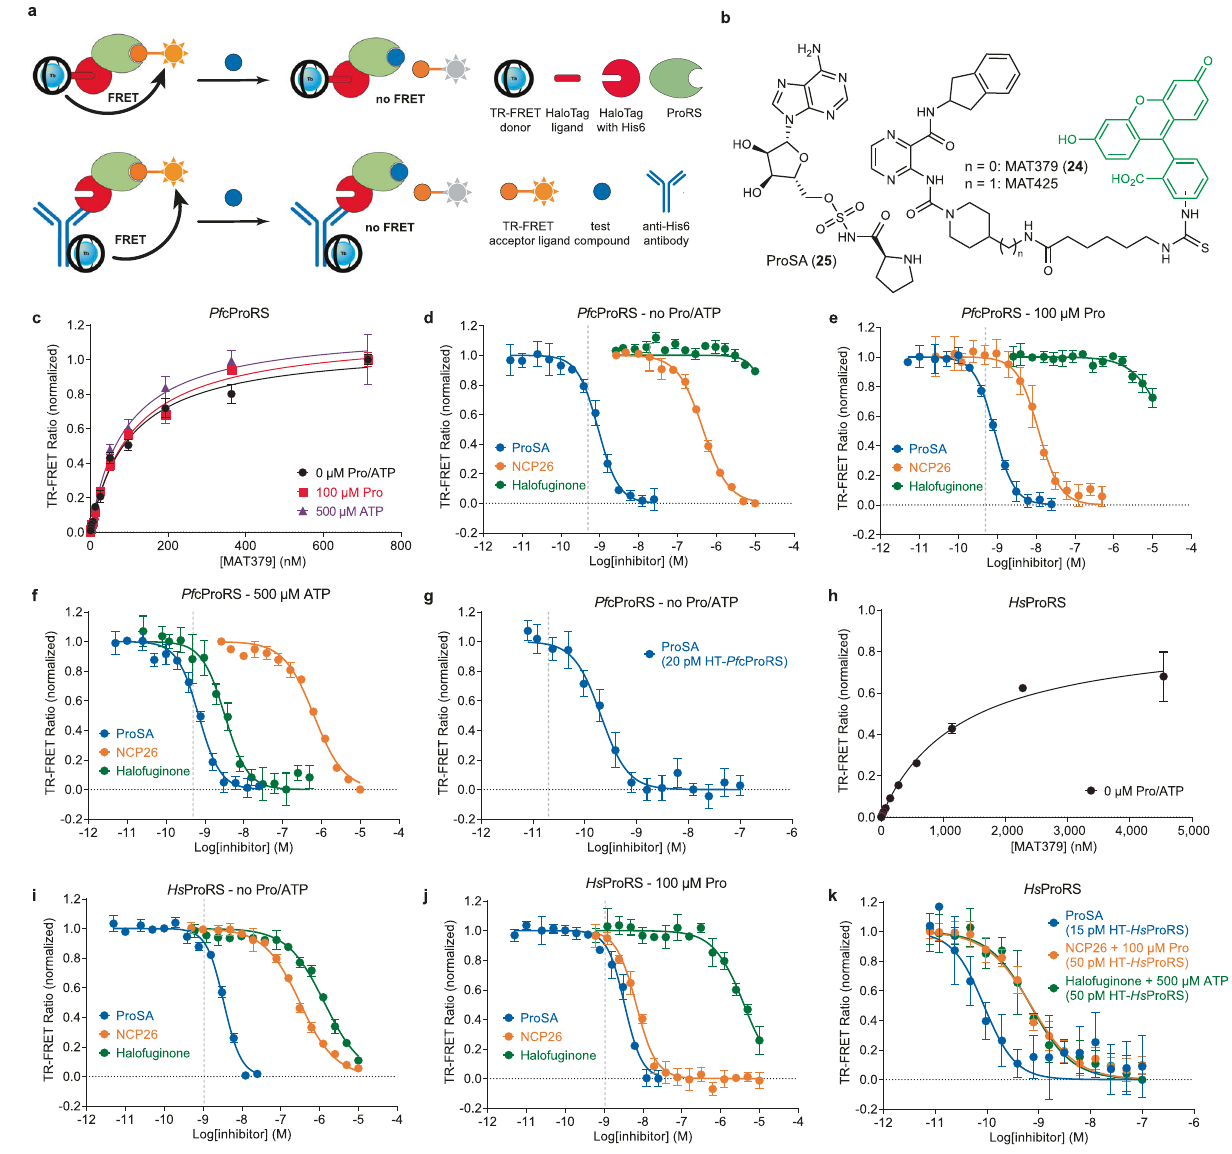
Fig. 2 | TR-FRET-based ProRS assay design and validation. a Principle of His6- HaloTag-ProRS (HT-ProRS) ligand displacement assay. The TR-FRET donor is installed either via labeling of the HaloTag with CoraFluor-1-functionalized HaloTagligand(CoraFluor-1-Halo)and/orusingaCoraFluor-1-labeledanti-His6 antibody(CoraFluor-1-Pfp) 32 .PositiveTR-FRETsignalisobserveduponbinding of a suitable tracer labeled with a compatible fl uorescence acceptor. Displace- mentofthetracerbyatestcompounddisruptsthesignal. b Chemicalstructures of ProSA ( 25 ) and tracers MAT379 ( 24 ) and MAT425. c Saturation binding of MAT379 to CoraFluor-1-labeled HT- Pf cProRS (1nM) in the absence (black) or presence of 100 μ M Pro (red) or 500 μ M ATP (purple). TR-FRET ratios were background-corrected relative to 10 μ M ProSA (~20,000× K D ). Dose-response titrationofreferencecompounds(ProSA(blue),NCP26(orange),halofuginone (green)) using CoraFluor-1-labeled HT- Pf cProRS (0.25 – 1 nM) and MAT379 at 2.5x K D (250nM)intheabsence( d )orpresenceof100 μ MPro( e )or500 μ MATP ( f ). Under all conditions, ProSA is titrating HT- Pf cProRS. g Dose-response